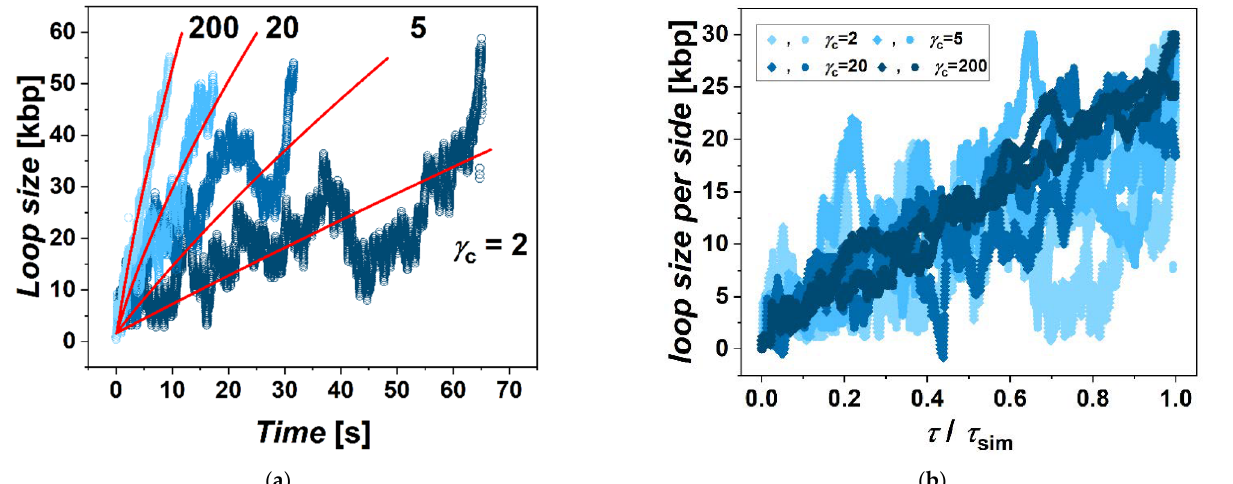
Figure 1. The simulations of loop extrusion. ( a ) The loop sizes are shown as a dependence of time for four settings of friction between cohesin ring and chromatin fiber γ c = 2, 5, 20 and 200. Graphs indicate that the rate of loop extrusion increases, with larger friction induced at the position of the ring. The red lines show the fits obtained by numerical solving of the system of differential equations proposed to describe the process of entropically driven extrusion (Equations (1) and (2)). ( b ) The progress of loop extrusion for individual arms of the loop in terms of their sizes is calculated as a difference of the position of the ring on the arm and the position of the motor. The graph shows that the extrusion becomes more stochastic for lower settings of γ c s, making the extrusion also more asymmetric.